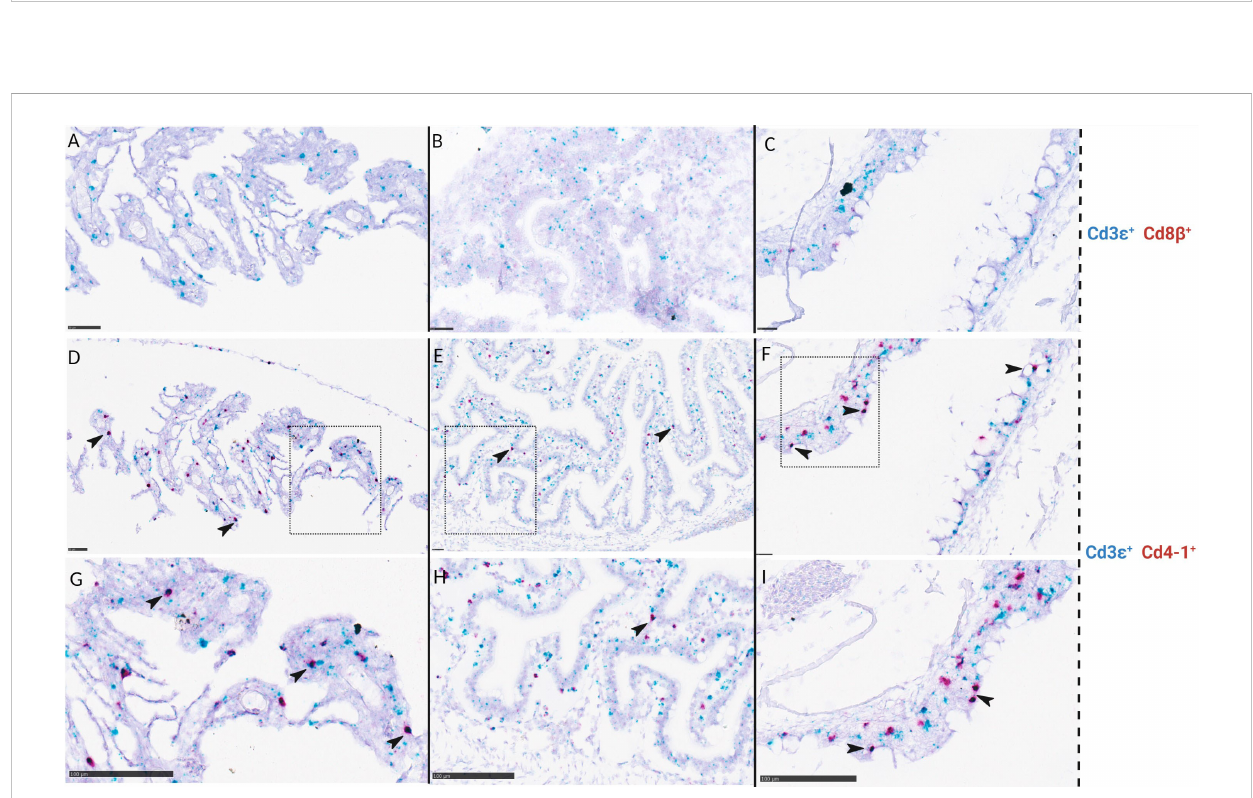
FIGURE 8 In situ hybridization of ballan wrasse juveniles (SL> 3,5 cm) shows differences in the amount of CD4-1 + cells compared to CD8 b + cells on serial sections of gills (A, D, and G) , gut (B, E, and H) , and pharynx (C, F, and I) . (A-C) are duplex assays using CD3 ϵ (blue) and CD8 b (red) RNA scope probes. (D-F) are duplex assays using CD3 ϵ (blue) and CD4-1 (red) RNA scope probes. Areas delimited by a box in (D-F) are shown in higher magni fi cation in (G-I) respectively. Arrows indicate putative CD3 ϵ + CD4-1 + lymphocytes. Scale bars: (A) 50 µm, (B) 25 µm, (C) 25 µm, (D) 50 µm, (E) 25 µm, (F) 25 µm, (G-I) 100 µm.